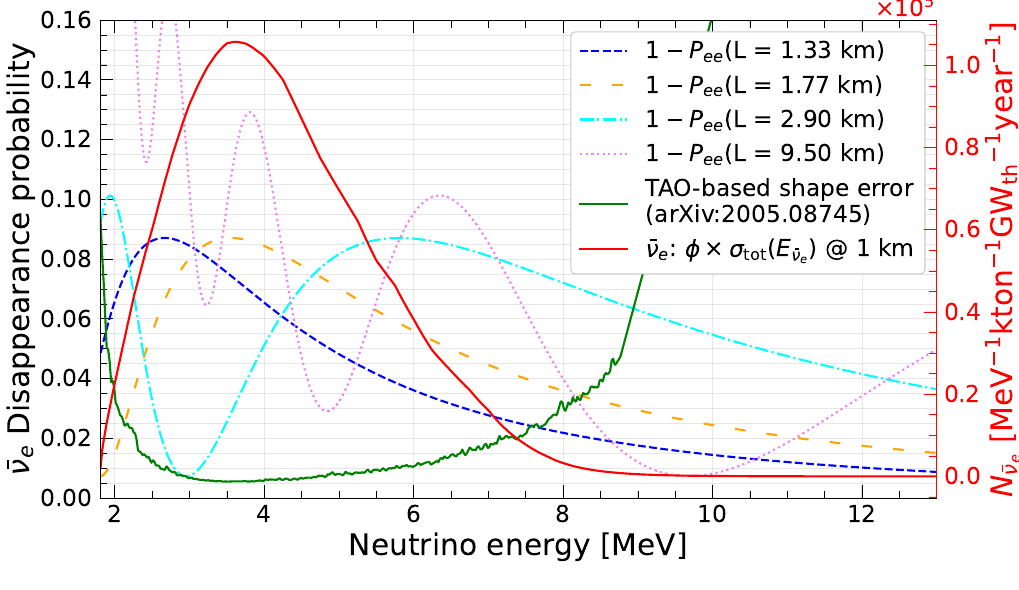
Figure 1 . The unoscillated measurable reactor antineutrino energy spectrum φ × σ tot ( E ¯ ν multiplied by the total IBD cross-section) at 1 km and the ν e disappearance probability 1 − P ee at different baselines. For a single detector, the rate uncertainty would mimic the oscillation pattern of sin 2 θ 13 / ∆ m 2 when the oscillation maximum is at the peak of the antineutrino spectrum. The 31 relative spectral shape uncertainty constrained by the TAO experiment (green line, same y-scale as left y-axis) [71] shows that the most precise neutrino energy region is 3–6